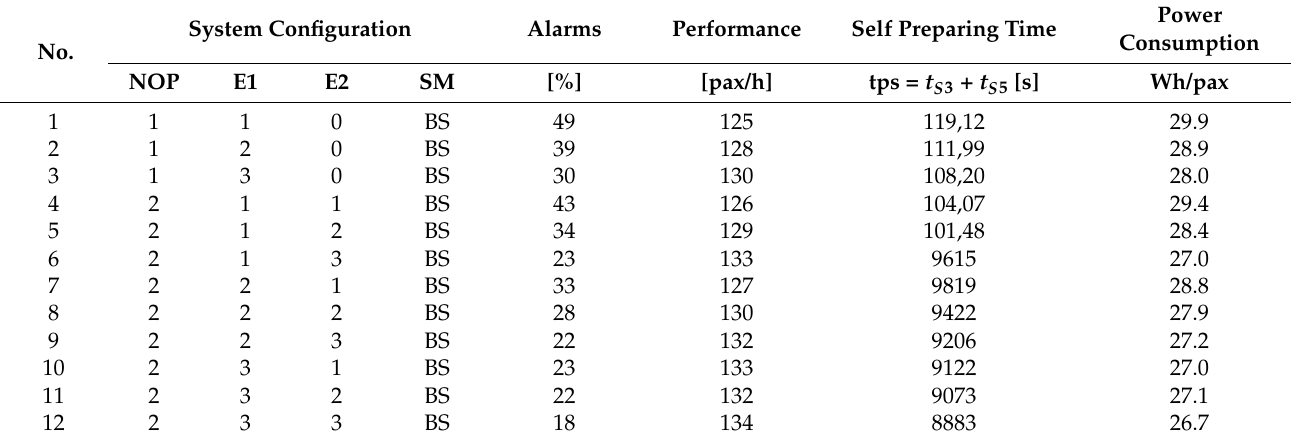
Table 5. Results for the BS detection method.